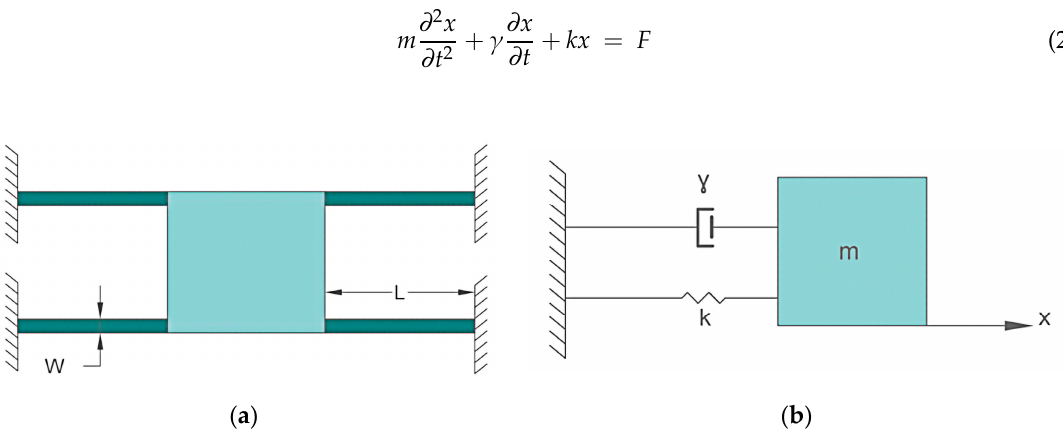
Figure 1. ( a ) Typical capacitive accelerometer with uniform flexures. ( b ) Basic mechanical mass– spring damper model. damper